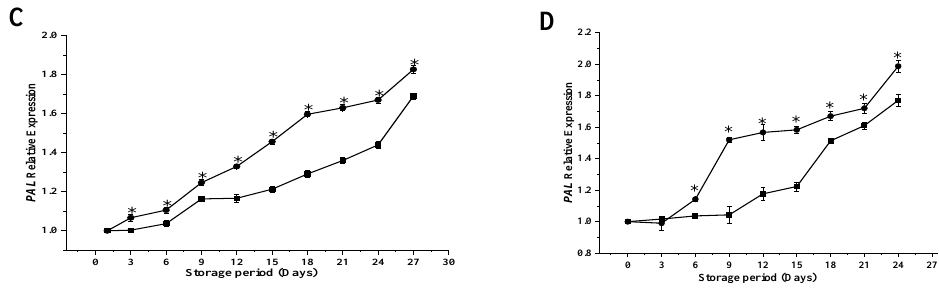
Figure 9. PAL relative gene expression ( A , B ) and PPO relative gene expression ( C , D ) of ‘Guiqi’ ( A , C ) and ‘Tainong 1’ ( B , D ) fruits treated with 1000 µ mol L − 1 MT. Each value is the mean for three replicates and vertical bars indicate the standard error (SE). Error bars with an asterisk (*) on the same storage period show a significant difference between the treatments ( p < 0.05).